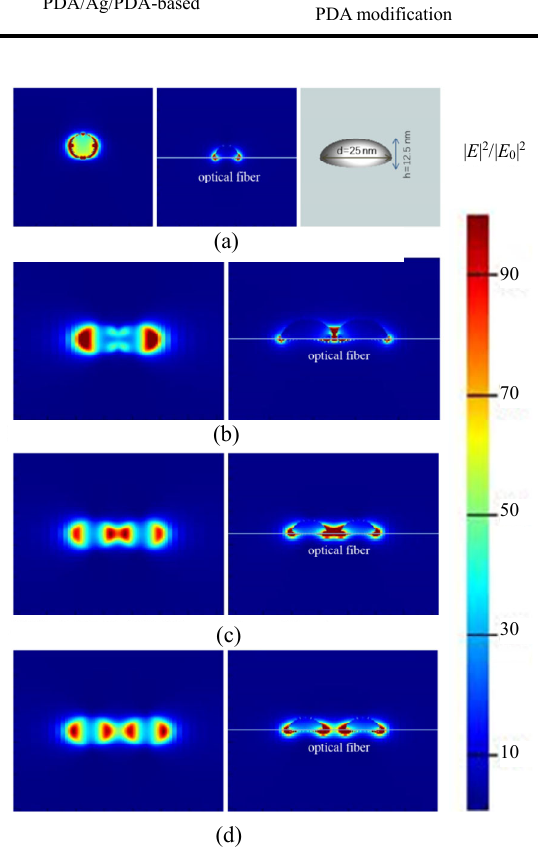
Fig. 3 Calculated electric field distributions (| E | 2 /| E 0 | 2 ) of the Ag NPs on the optic fiber surface when the particles existed as (a) a single NPs, (b) a dimer without gap, (c) a dimer with a 10 nm gap, and (d) a dimer with a 15 nm gap (the left demonstrates the top view; the right shows the side